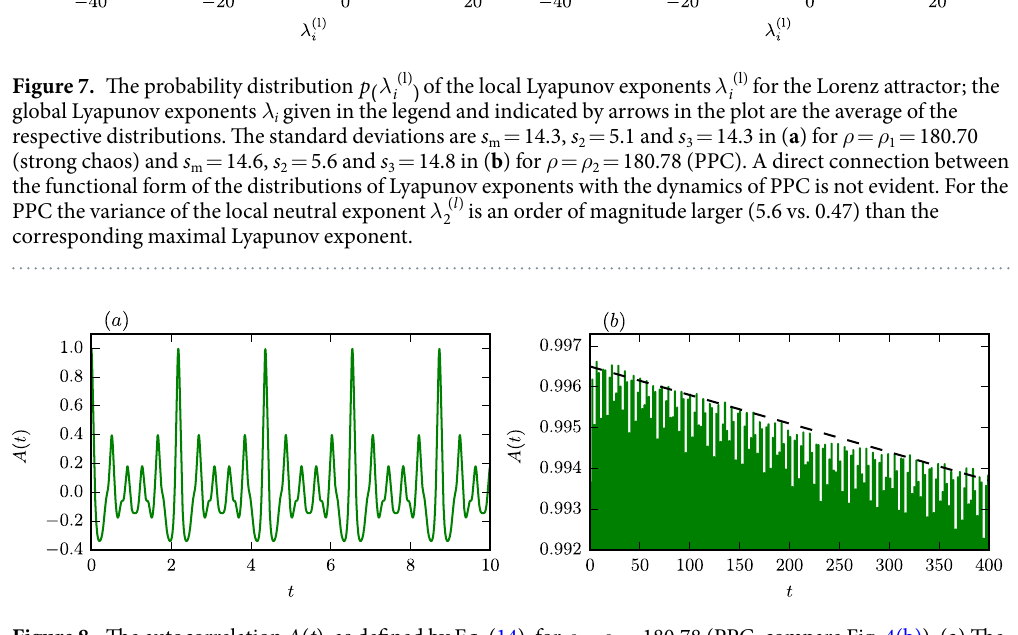
Figure 8. The autocorrelation A ( t ), as defined by Eq. (14), for ρ = ρ 2 = 180.78 (PPC, compare Fig. 4(b)). ( a ) The oscillations resulting from looping around the braids are spaced by τ ≃ 2.2. ( b ) On longer timescales the auto- correlation decreases linearly, with the dashed line corresponding to 0.9965 − 7 · 10 − 6 t